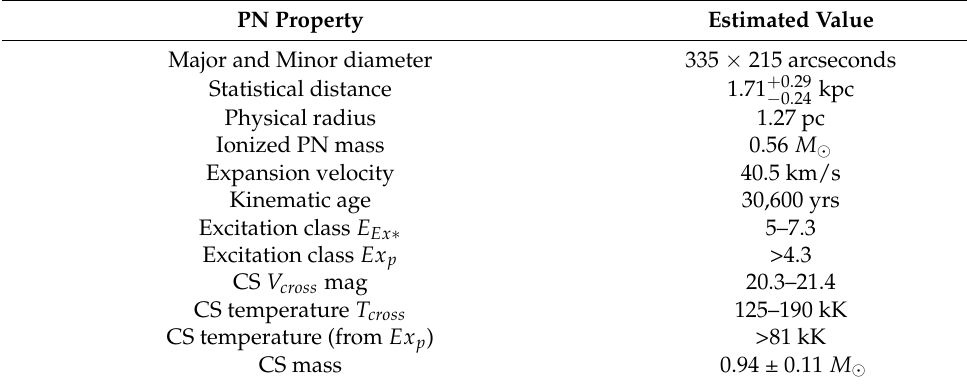
Table 1. Physical properties of the PN BMP